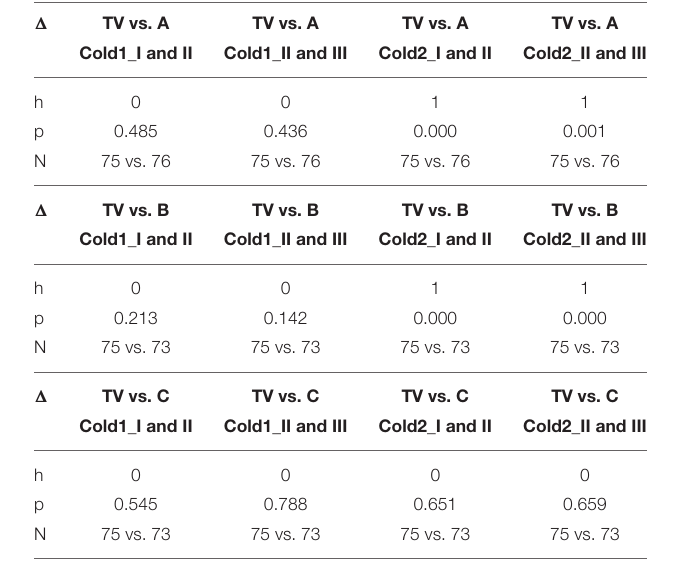
TABLE 2 | Testing for statistically significant changes in normalized SCL for Cold1 (before treatment) and Cold2 (after treatment) across sessions on different days.